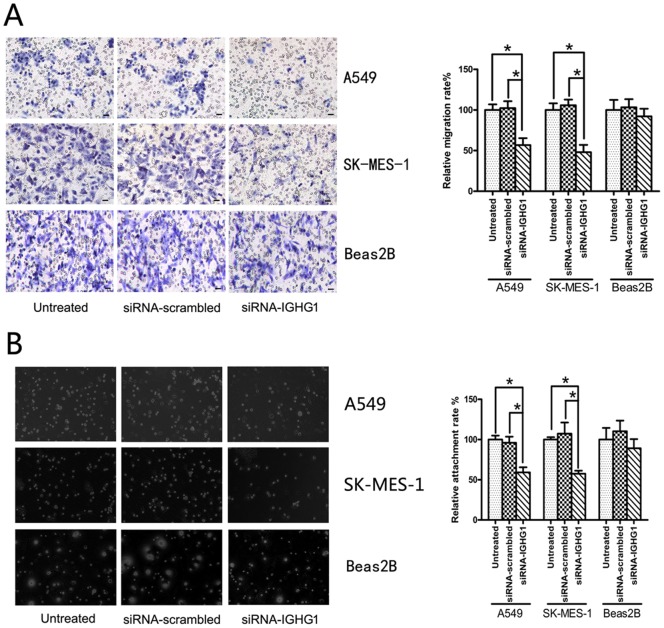
IgG down-regulation inhibits lung cancer cell migration and attachment.With specific IGHG1 siRNA transfection, the ability of migration and attachment of lung cancer cells was reduced markedly in A549 and SK-MES-1 cells, whereas not in Beas2B cells. A, representative photographs (200×) of transwell assays. B, representative photographs (200×) of attachment assays. The histograms represent the four independent assays. Data are presented as mean ± S.E. *, p<0.05.